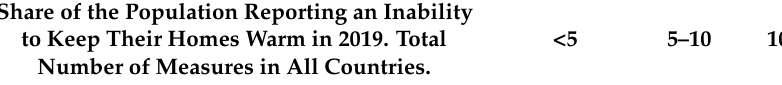
Table 1. Energy justice—focused policies during the COVID-19 pandemic in groups of European countries with different rates of energy poverty, based on the data and classification developed by Hesselman et al. [108]. See the Supplementary File for individual country listings. Share of the Population Reporting an Inability to Keep Their Homes Warm in 2019. Total <5 5–10 10–20 >20 Number of Measures in All Countries. Regulatory action 7 6 6 3 Subsidies on energy bills Other